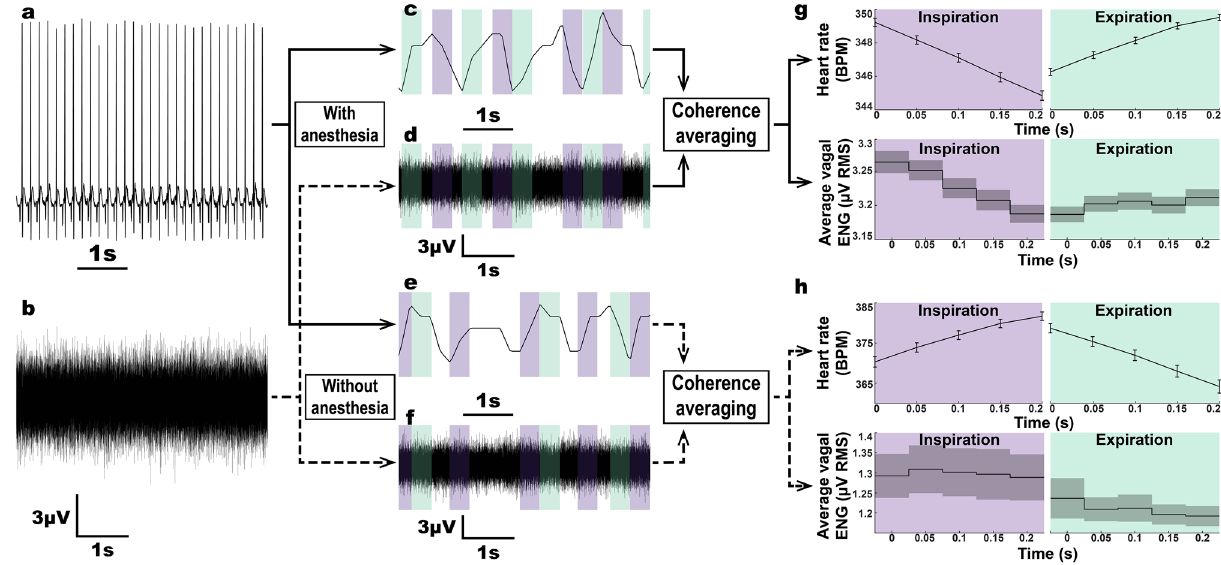
Figure 4. Calculation of respiratory vagal difference (RVD) using heart rate to signal respiration. ( a,b ) Simultaneous recording of ECG ( a ) and vagal ENG ( b ). ( c ) Anesthetized ECG is used to calculate heart rate. Periods of increasing (green—expiration) and decreasing (purple—inspiration) heart rate are identified. ( d ) Filtered vagal ENG is divided into increasing/decreasing heart rate periods. ( e,f ) Steps described in panels ( c ) and ( d ) are repeated for non-anesthetized recordings, but inverted due to RSA reversal under anesthesia. ( g ) Average heart rate and vagal ENG during inspiration and expiration under anesthesia (sample data shown for a single 10-min recording). ( h ) Average heart rate and vagal ENG during inspiration and expiration without anesthesia (sample data shown for a single 10-min recording). RVD is calculated as the difference in vagal RMS between expiration and inspiration over a 10-min period.